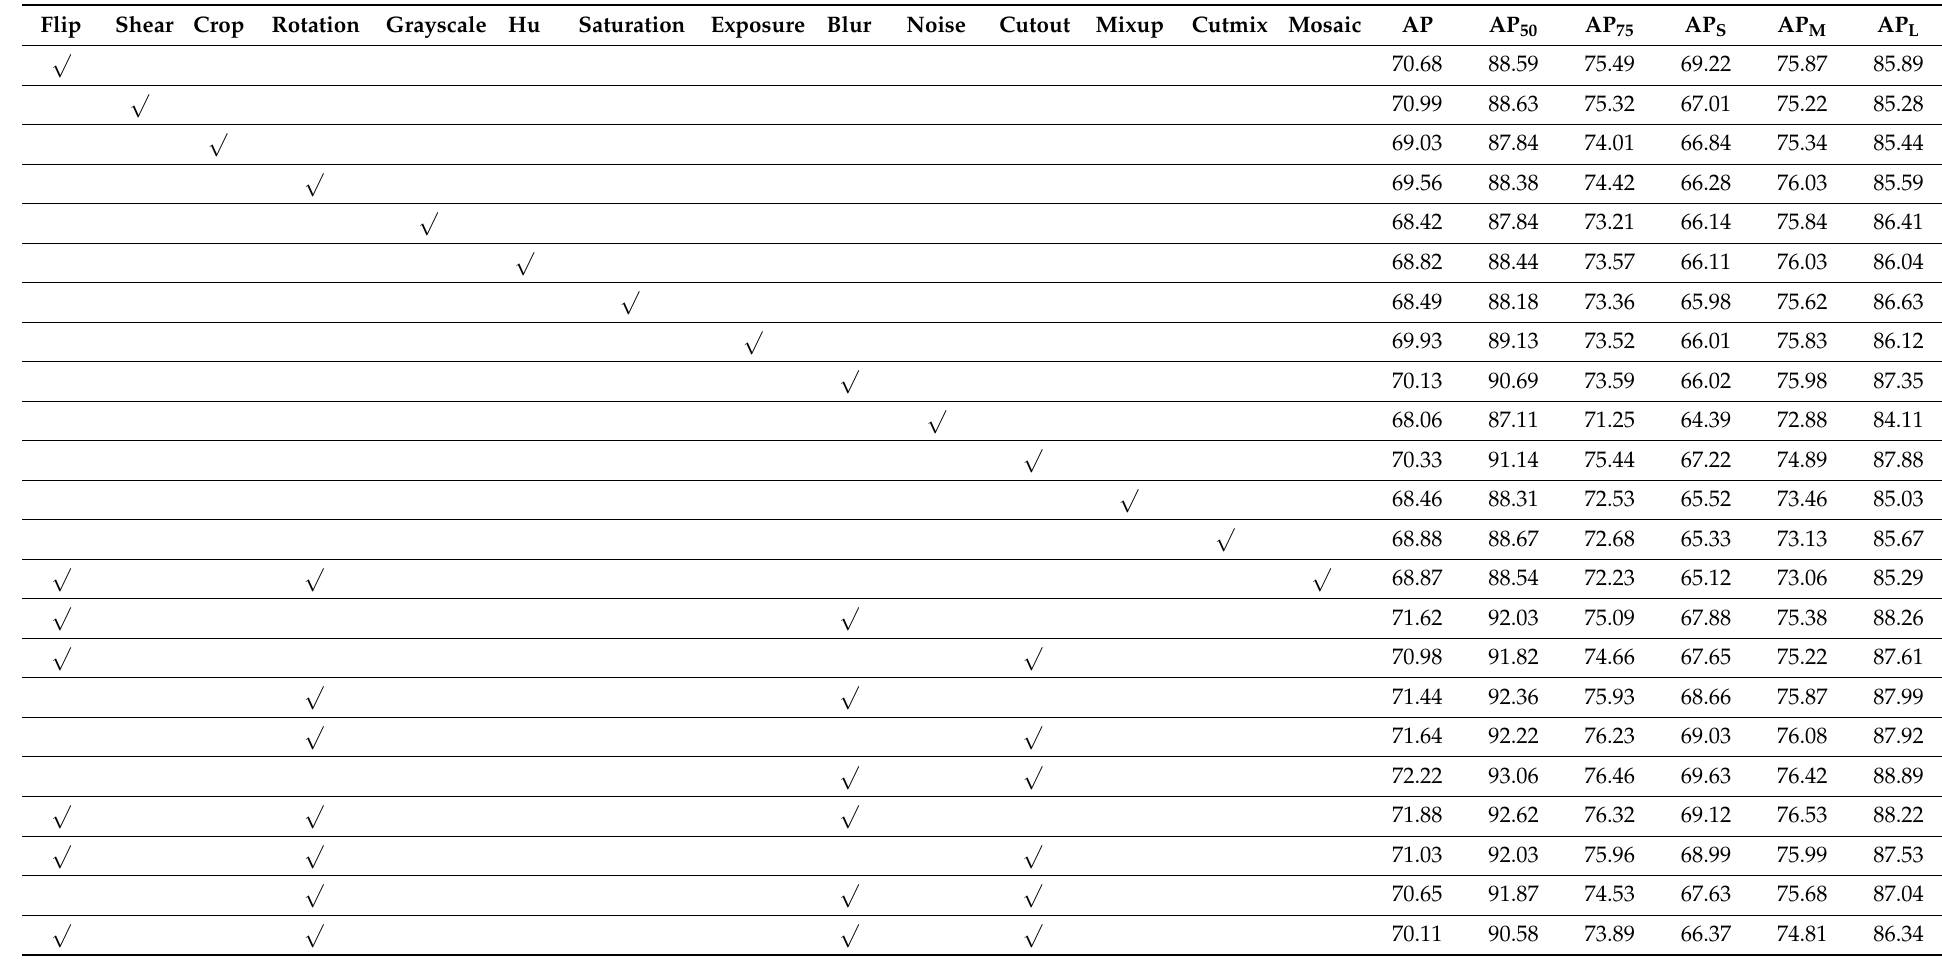
Table 2. Comparison with different data enhancement